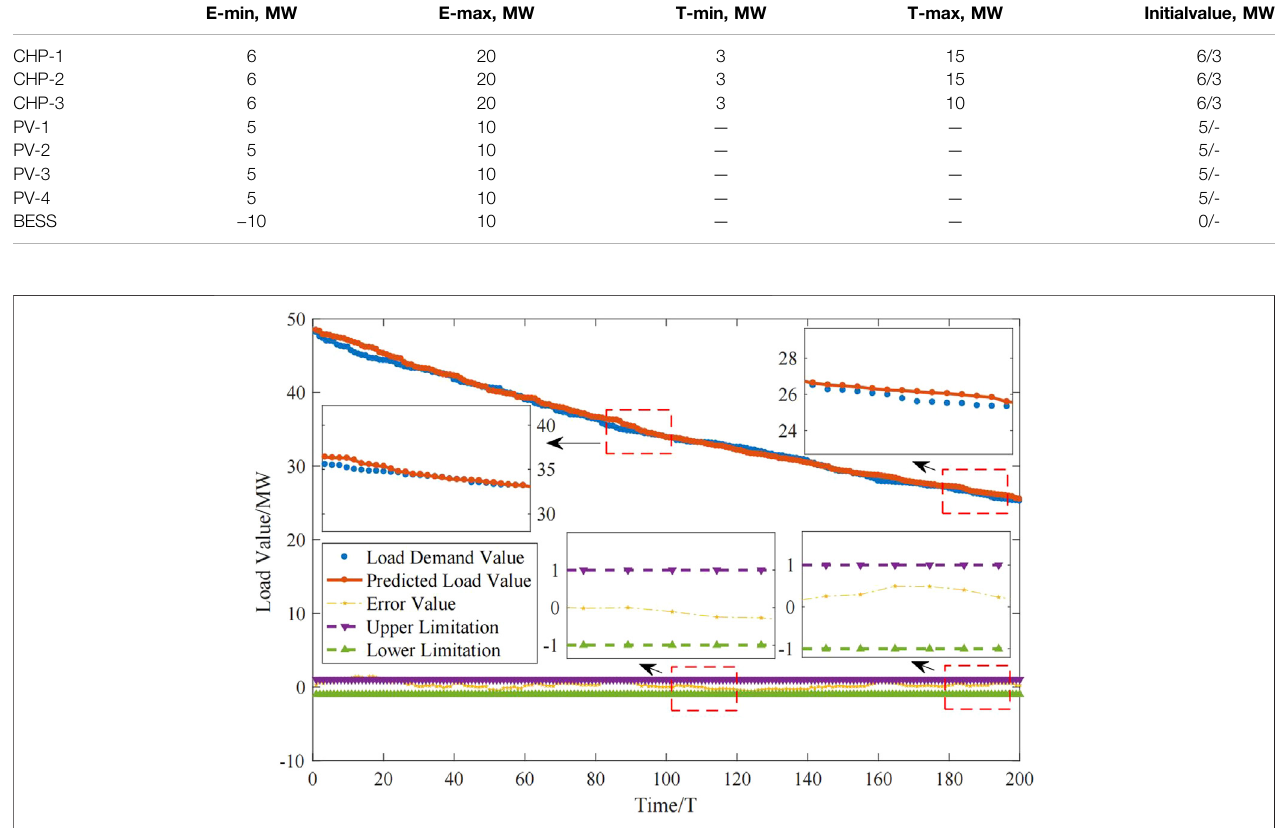
FIGURE 6 | Load forecasting trajectory of electricity